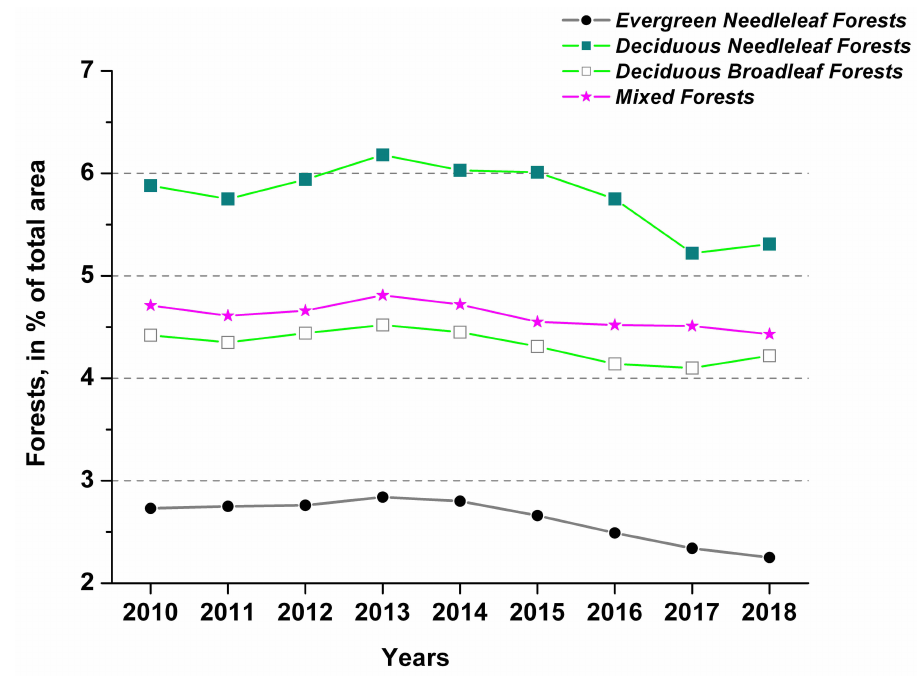
Figure 4. The interannual variability of areas occupied by evergreen needleleaf, deciduous needleleaf, deciduous broadleaf, and mixed forests as a percentage of the Russian basin of Lake Baikal, is presented as a function of time for the period 2010–2018, considered in this paper. The vegetation types in MCD12C1 correspond to IGBP classes.